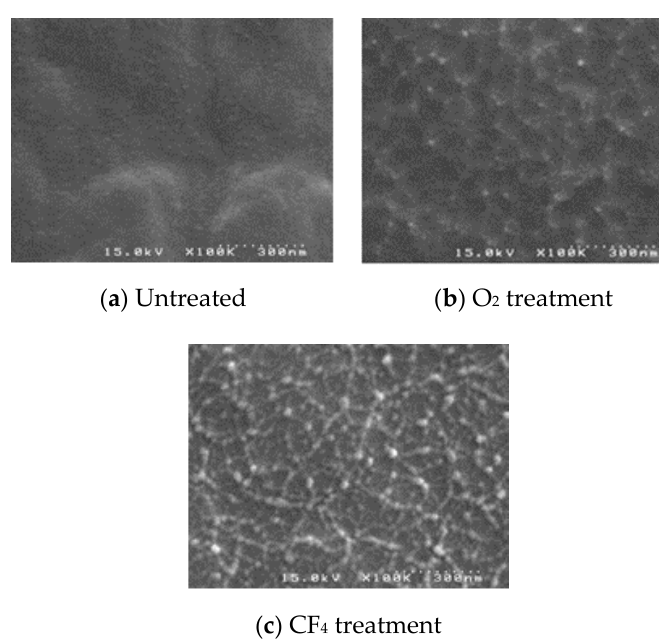
Figure 2. Test sample fabrication process.